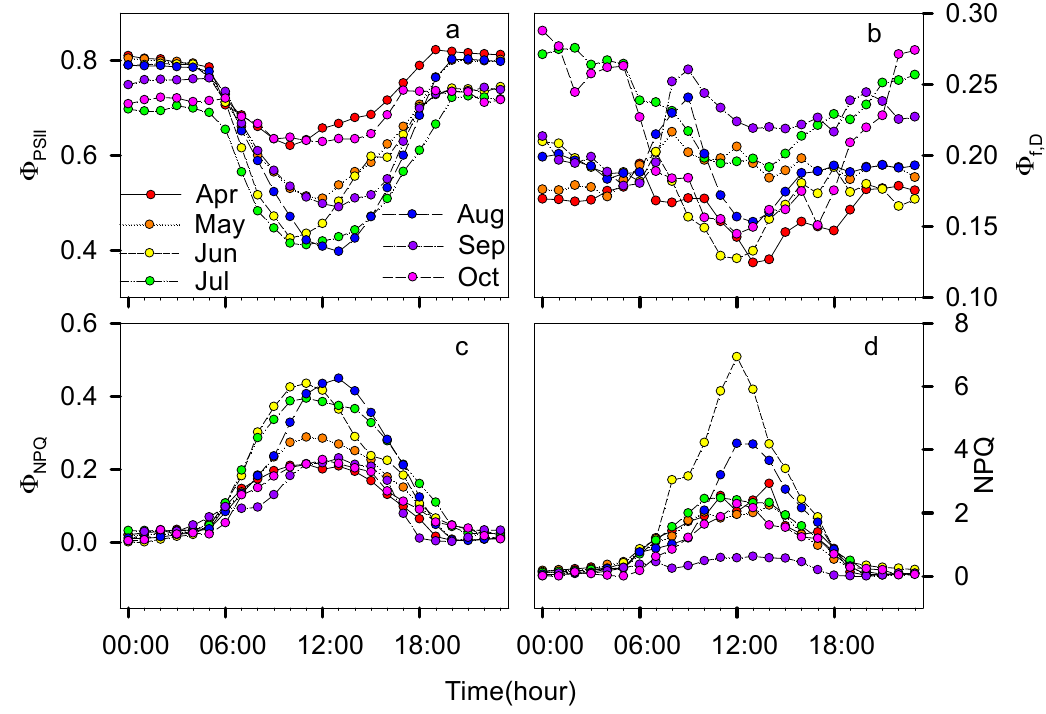
Figure 3. Monthly mean diurnal cycle of energy partitioning in Salix psammophila during the growing season (April–October) of 2012, including actual quantum yield of PSII photochemistry ( Φ PSII , ( a )), non-regulated energy loss ( Φ f,D , ( b )), regulated thermal energy loss ( Φ NPQ , ( c )), and non-photochemical quenching coefficient (NPQ, or Stern-Volmer quenching, ( d )).